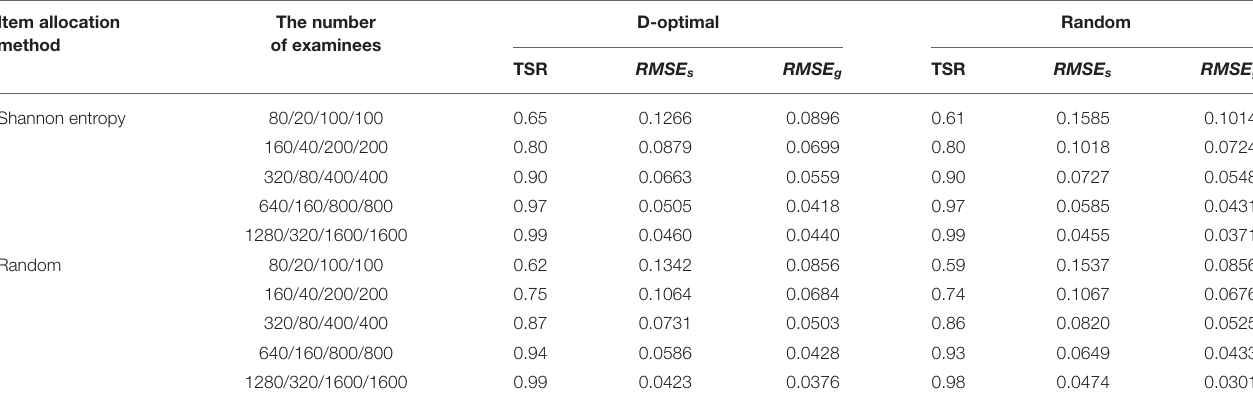
TABLE 5 | The TSR and the RMSE under different allocation strategies with iterations. Item allocation method